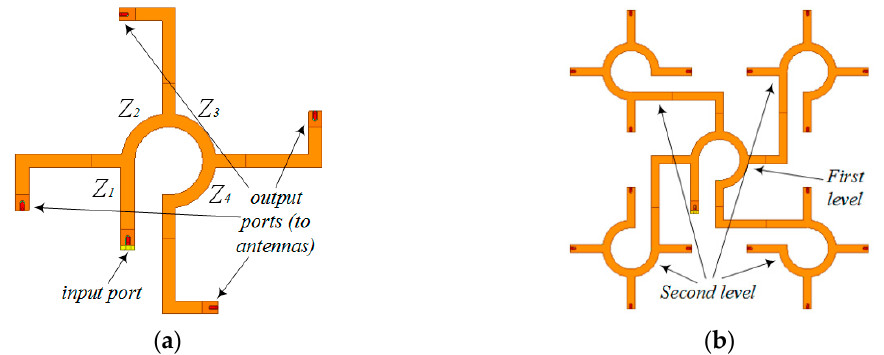
Figure 2. Representation of antenna array feed networks: ( a ) one level and ( b ) two levels of sequential rotation (SR).